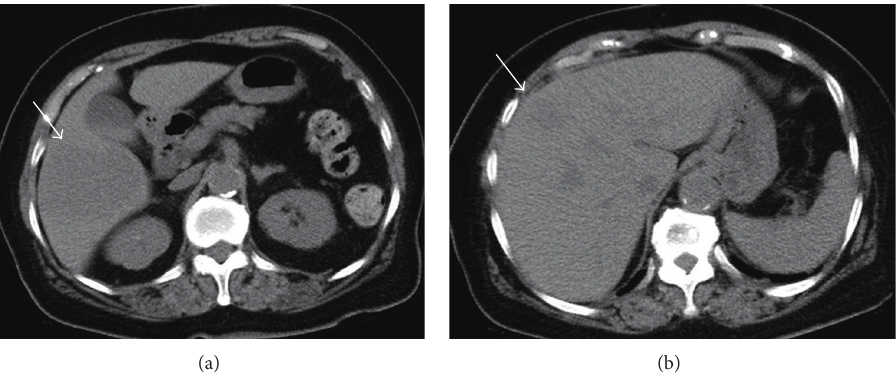
Figure 1: Noncontrast abdominal computed tomography. Low-density masses were revealed at segments 5 and 8, suggestive of a liver abscess ((a) and (b)).